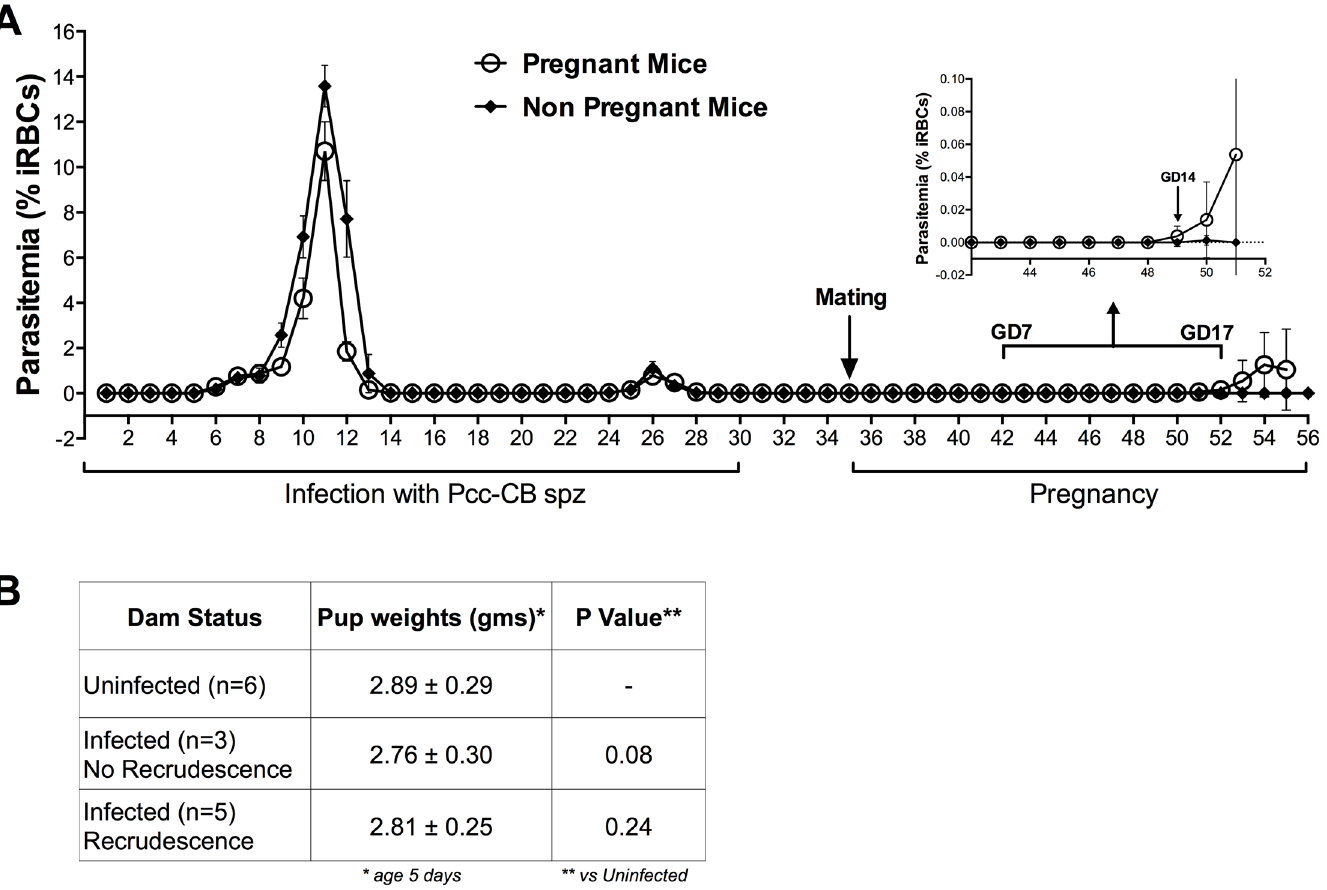
Fig 1. Recrudescence of P . chabaudi in mice during pregnancy. After a primary infection initiated by inoculation of Pcc- CB sporozoites, mice were paired with males at 35 days post-inoculation ( “ Pregnant Mice ” , n = 16) or remained unpaired ( “ Non Pregnant Mice ” , n = 12). Parasitemia was monitored by daily blood smears throughout the study. Data are presented as means with 95% confidence intervals. Experiment was repeated with similar results.